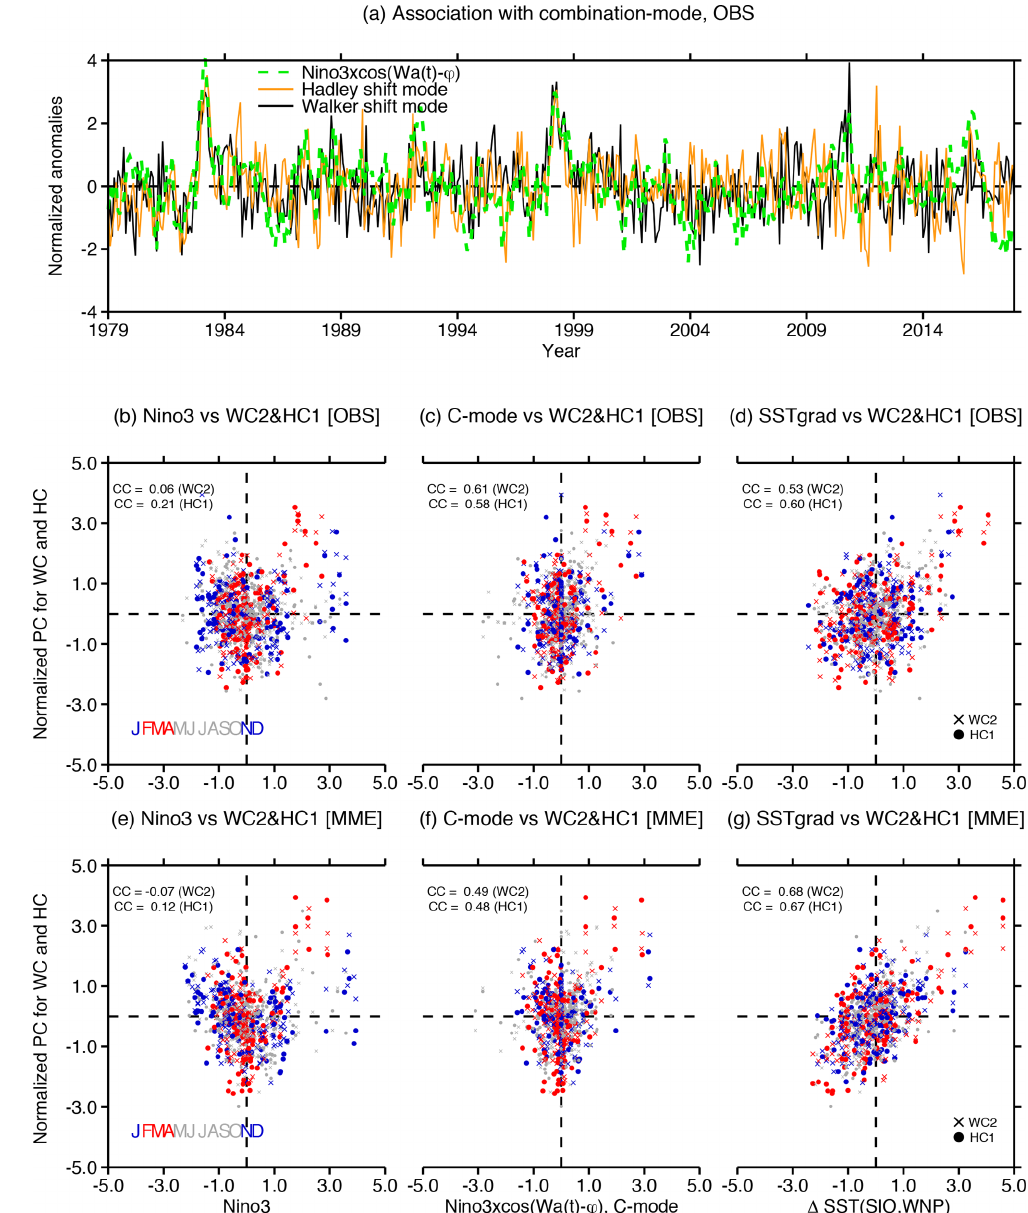
Figure 3. Seasonal dependency of phase-synchronized spatial shifts of the HC and WC. (a) The normalized PC time series of the shift modes (i.e., WC2 and HC1) and the combination mode (Stuecker et al., 2013; dashed green line). (b–g) Scatterplot of normalized time series for SST anomalies ( x axis) versus PCs of WC2 ( x symbol) and HC1 ( y axis), obtained from the observations (1979–2017; b – d ) and the AMIP MME (1979–2014; e – g ): (b, e) Niño3, (c, f) combination mode, and (d, g) SST gradient between southern Indian Ocean (20–5 ◦ S, 90–120 ◦ E) and western North Pacific (0–15 ◦ N, 140–170 ◦ E) (SSTgrad). Each season is displayed in different colors.